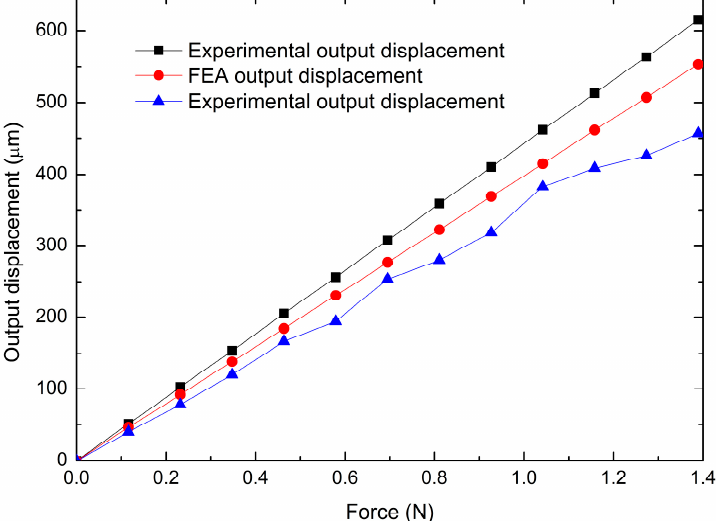
Figure 17. Comparison of the total output displacement of the MG, obtained from experimental tests and theoretical and FEA results. and theoretical and FEA